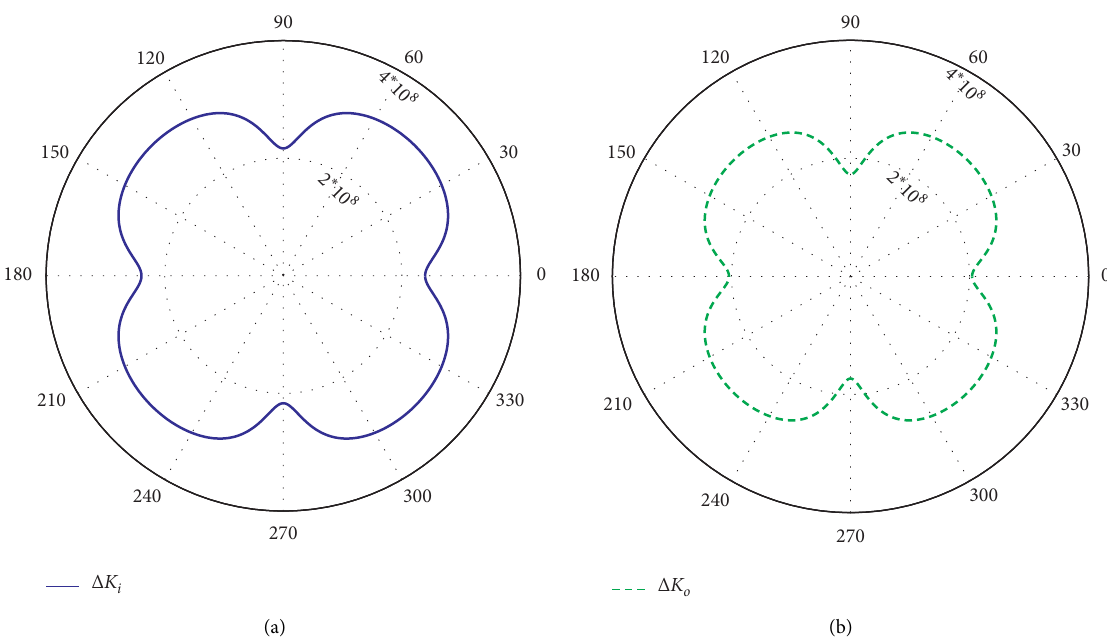
Figure 15: Difference of contact rigidity between rigid bearing and flexible bearing. (a) Contact stiffness difference of inner ring △ K (b) Contact stiffness difference of outer ring △ K o